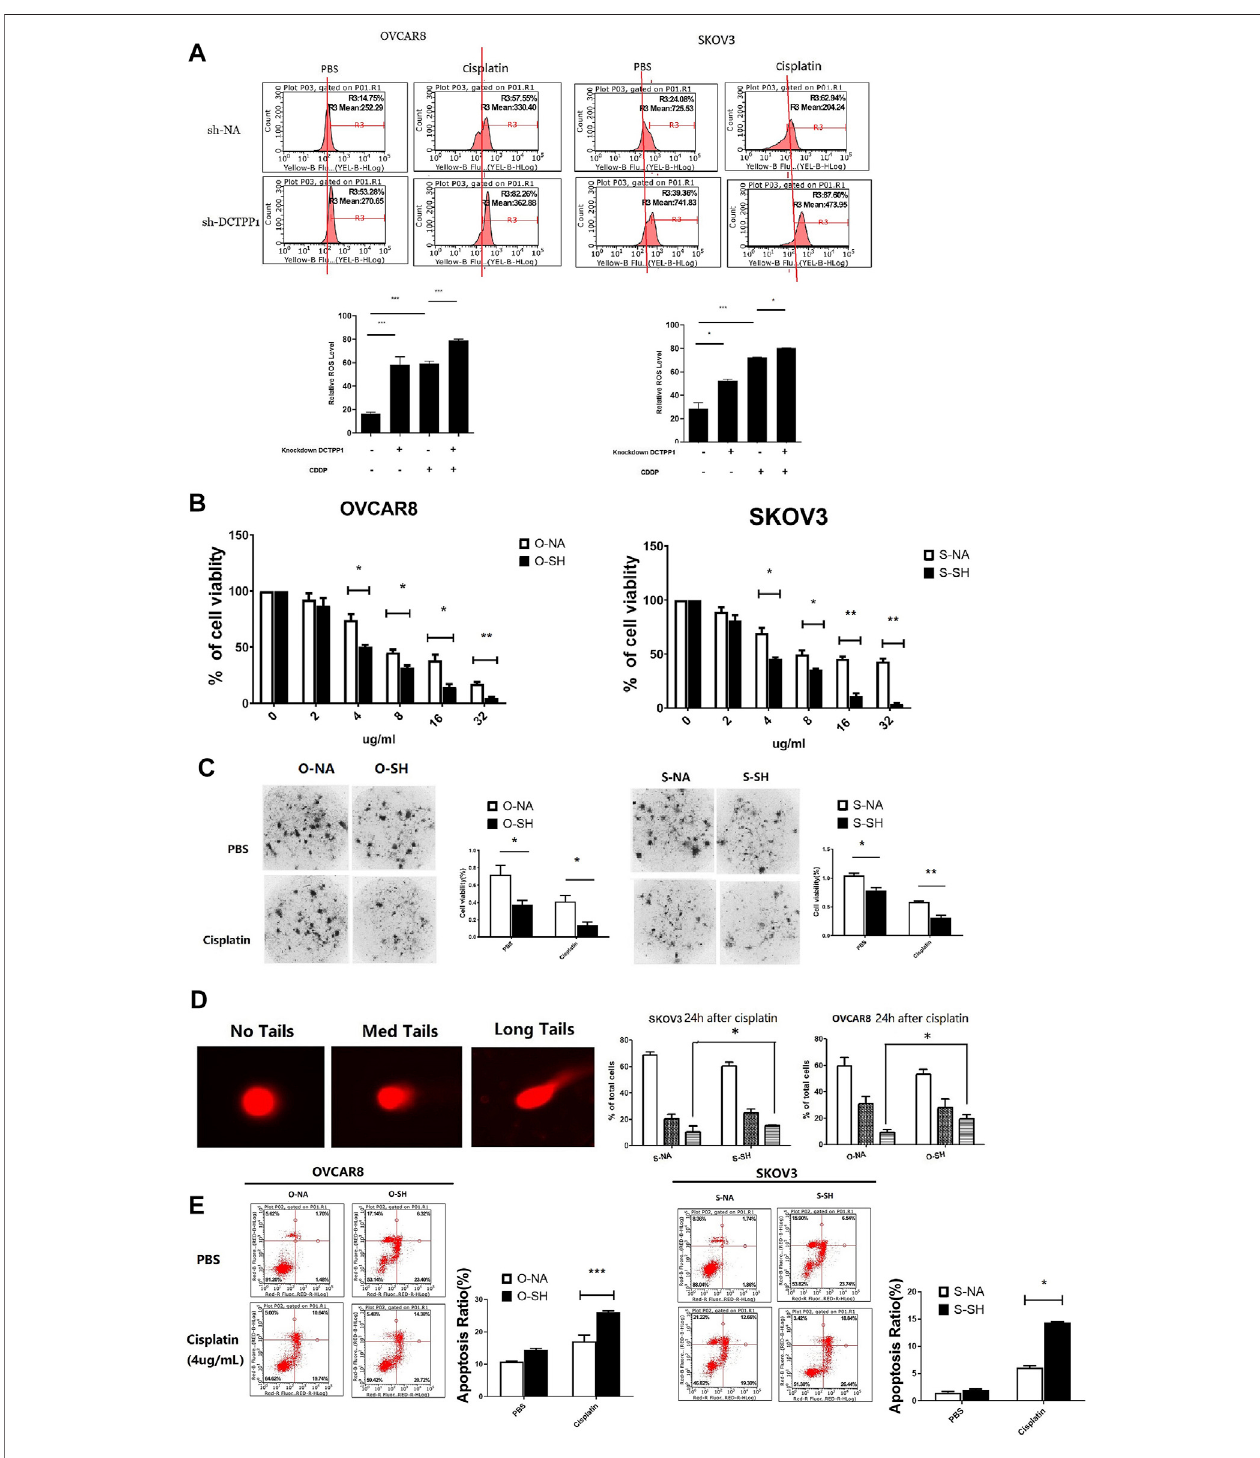
FIGURE 5 | DCTPP1 knockdown increases cisplatin-sencitivity in cisplatin-sensitive ovarian cancer cells. (A) The level of reactive oxygen species (ROS) was detected using DHE in control or DCTPP1 knockdown cells treated or without treated with cipalin (4 μ g/ml).* p < 0.05; ***, p < 0.001. (B) DCTPP1 knockdown inhibit cell viability both in SKOV3 and OVCAR8 cells treated with cisplatin of different concentration (0, 2, 4, 8, 16, and 32 μ g/ml). * p < 0.05; **, p < 0.01; (C) Clone-formation of ovarian cancer cellsinfected with lentiviral DCTPP1shRNA and a controlshRNA, wasmeasured bythe CD-DST assay. *, p < 0.05; **, p < 0.01. (D) Alkalinecomet assay data is shown the indicated samples. Representative single cell images used for scoring within the three categories are shown next to the quantitation. * p < 0.05. (E) Apoptosis was analyzed by fl ow cytometry. Representative plots showing the redistribution of phosphatidylserine (annexin V staining) in the presence of propidium iodide (PI). Statistical analysis of apoptosis of cells exposed to PBS and cisplatin, respectively. * p < 0.05; ***, p < 0.001.